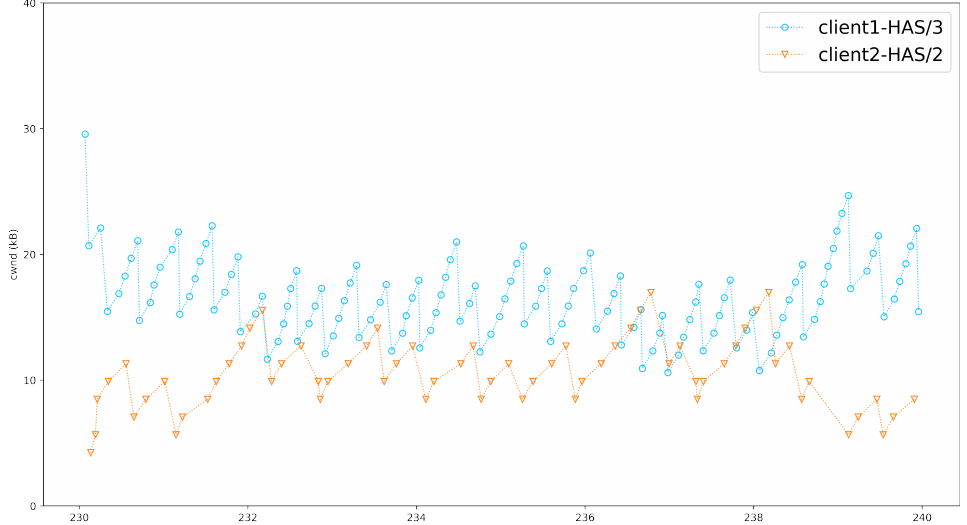
Figure 7. An example zoomed-in time-varying cwnd of the clients using the fairness ABR under the scenario S 11 with B = 3 (mbps).